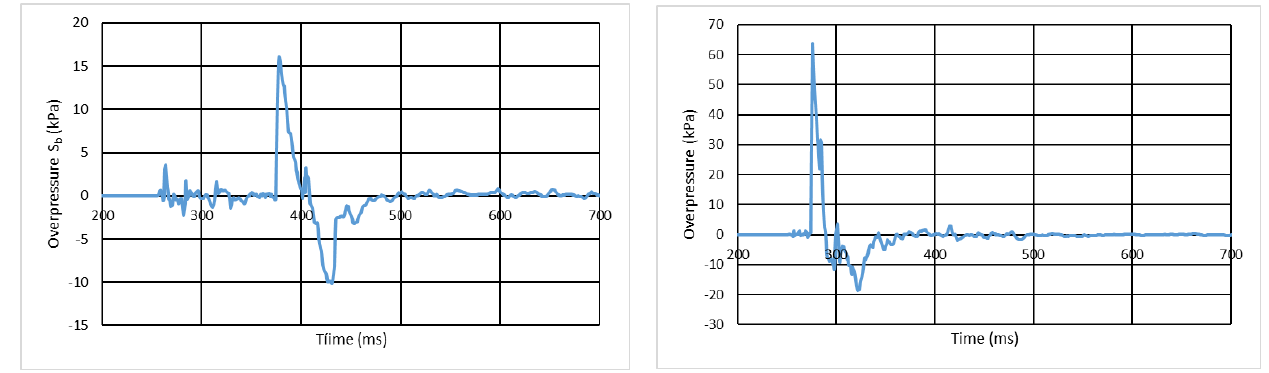
Figure 7. Air overpressure measured in tests no. 92 (left) and no. 95 (right).